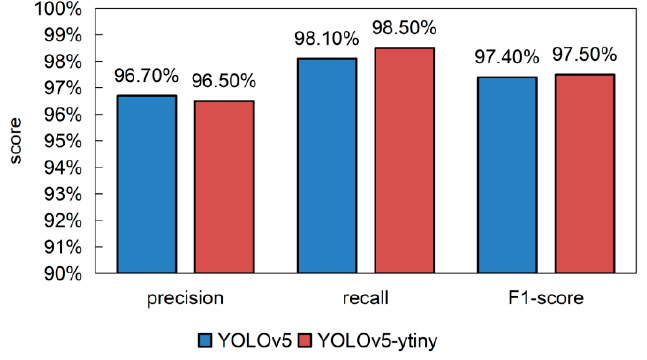
Figure 9. Comparison of model evaluation indicators.